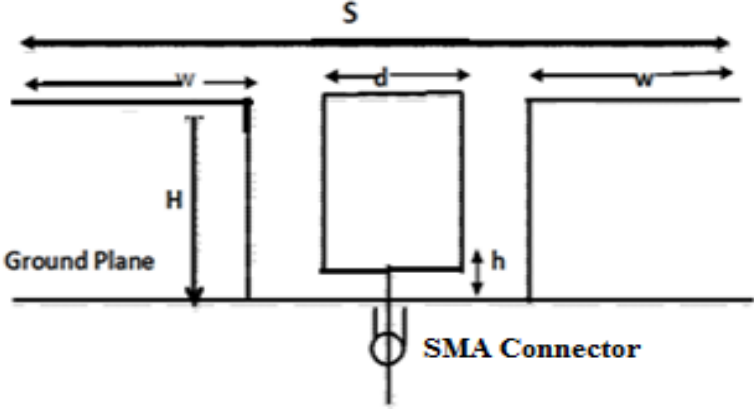
Figure 2a. Side view of the proposed antenna